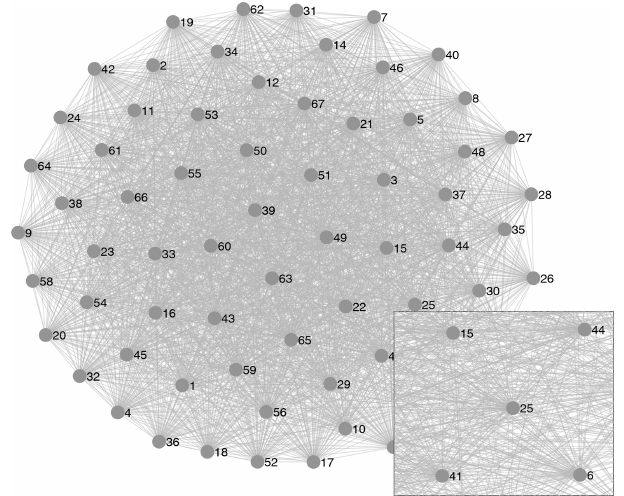
Figure 2. Graphical form of the network defined by temperature time series emphasizing the density of the network. Each node rep- resents a station in the network. Each edge represents a positive similarity between two stations. Note that this graph is not com- plete because low values of similarity ( < 0 . 1) are taken to be zero in this